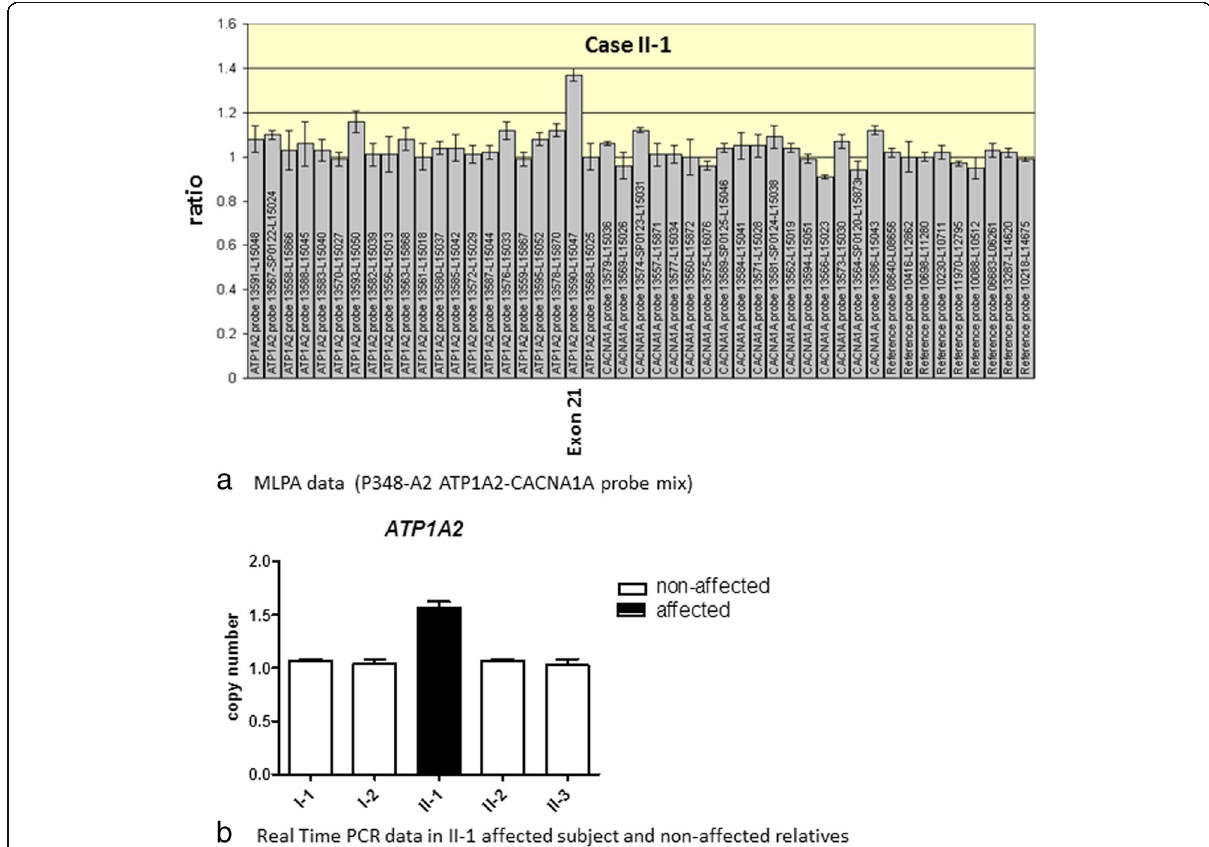
Fig. 3 a ATP1A2 duplication in SHM patient obtained by MLPA assay. For each probe, the ratio < 0.75 stands for deletion; and the ratio > 1.3 stands for duplication. b ATP1A2 quantification by Real Time PCR in patient and in unaffected